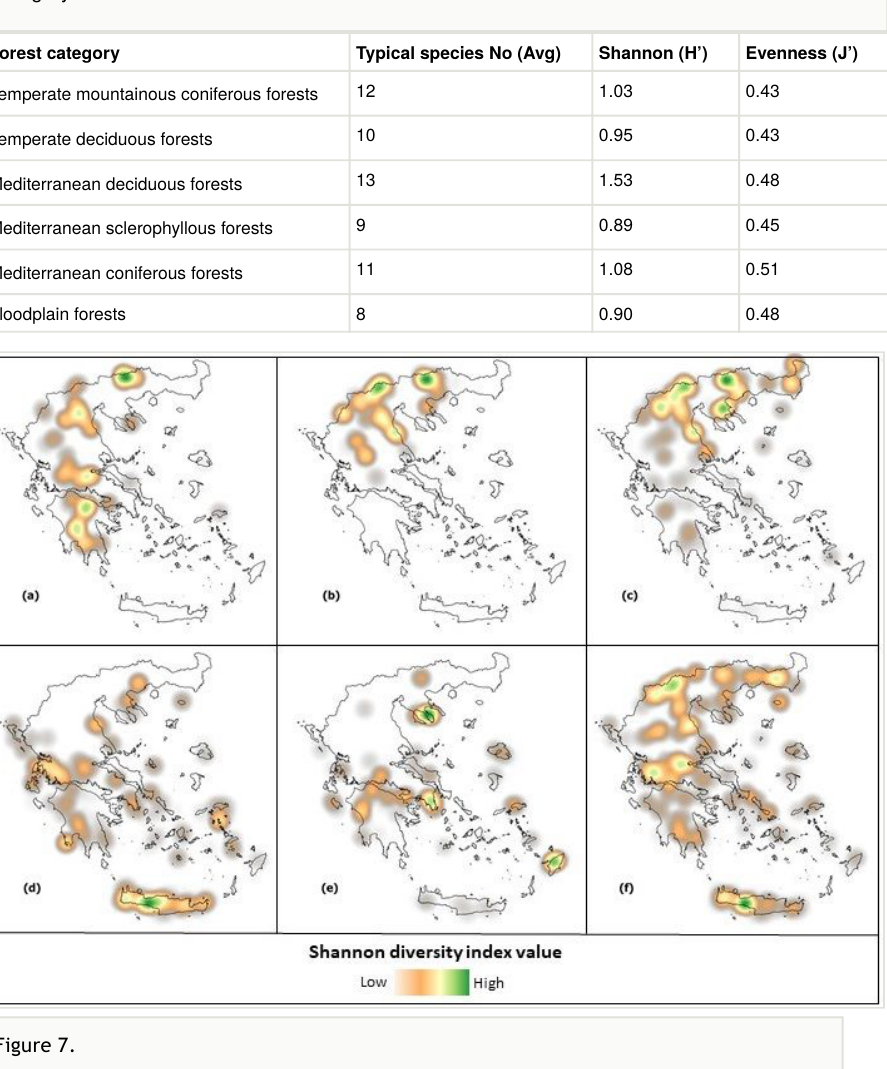
Heat-maps of Shannon diversity Shannon/index for the forest categories: (a) Temperate mountainous coniferous forests, (b) Temperate deciduous forests, (c) Mediterranean deciduous forests, (d) Mediterranean sclerophyllous forests, (e) Mediterranean coniferous forests and (f) Floodplain